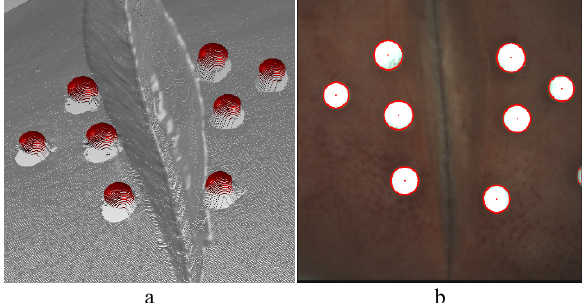
Figure 12. Target point detection; (a) point cloud and selected spherical points (red) of laser triangulation sensor; (b) measured ellipses in one image of the trinocular